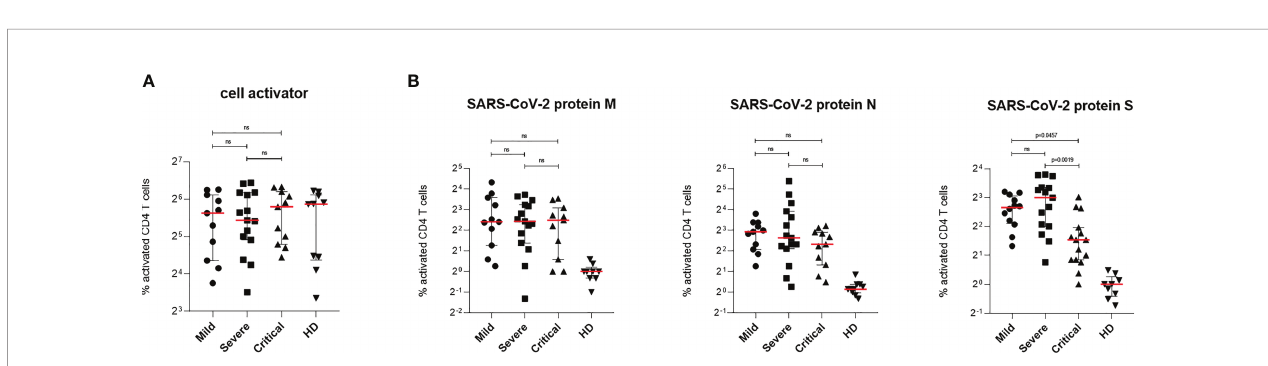
FIGURE 3 | SARS-CoV-2-speci fi c CD4 + T cells response in patients with mild, severe or critical COVID-19. PBMCs from COVID-19 patients and HD were stimulated for 6 h at 37°C using either cell activator cocktail or SARS-CoV-2 PepTivator ® peptide pools. Cells were fi xed after extracellular staining for CD4 + expression and then permeabilized. Intracellular staining was performed to determine polyfunctionality of T cells by measuring IL-2, IFN- g , TNF- a and MIP-1 b levels. Cells were analyzed by fl ow cytometry and activation was assessed by comparison of cytokine production with unstimulated cells. Polyfunctionality of T cells was increased in all three COVID-19 groups compared to HD group. (A) Percentages of activated SARS-CoV-2-speci fi c CD4 + T cells upon stimulation with cell activator cocktail are shown for each donor and medians are represented as red lines. (B) Percentages of SARS-CoV-2-speci fi c CD4 + T cells upon stimulation with peptide pools covering the complete SARS-CoV-2 proteins M (left), N (middle) or S (right) are illustrated. Statistical variability is presented as interquartile range. Statistical differences were determined using two-tailed unpaired student ’ s t-test. ns, not signi fi